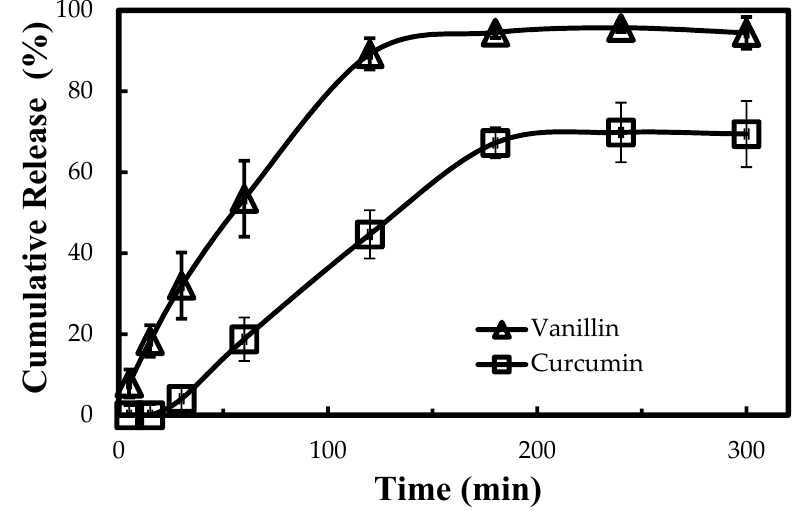
Figure 6. Cumulative release of vanillin and curcumin from phospholipid fibers into phosphate buffered saline (PBS), pH = 7.6 (n = 3). The error bars in the figure represent the standard deviation (SD).